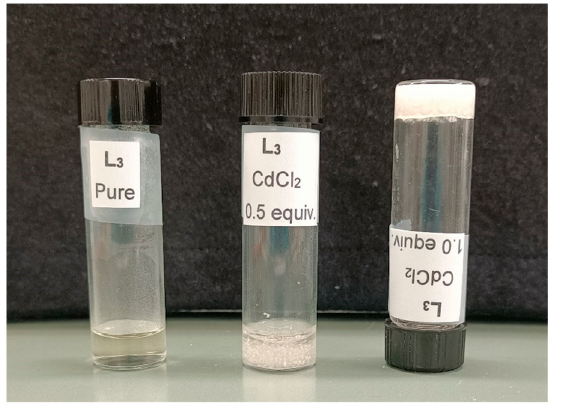
Figure 8. Stimuli-responsive behavior of L 3 at 0.7 wt% in the presence of CdCl 2 .